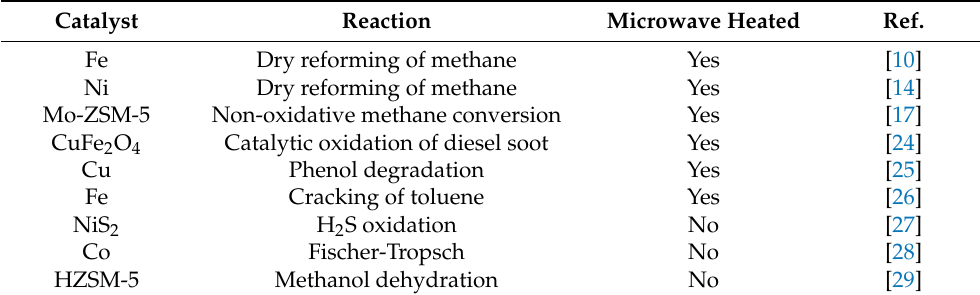
Table 1. Applications of SiC as catalytic support in reaction systems.